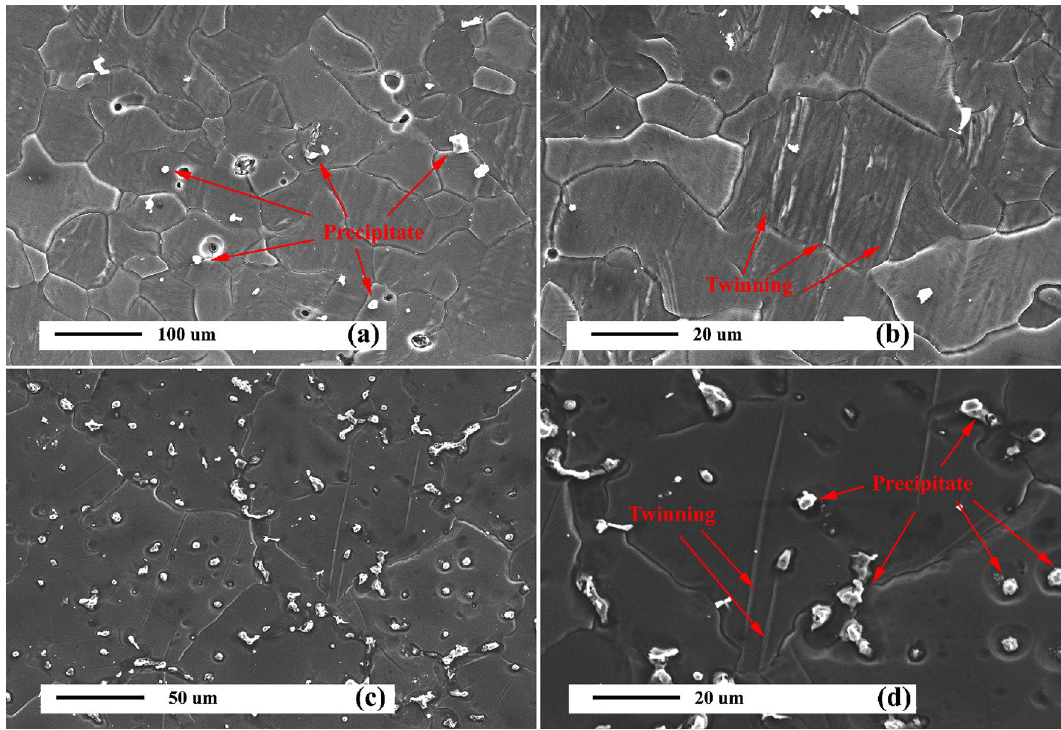
Figure 4. SEM micrographs of unreinforced alloy: ( a ) and ( b ) as-cast, and ( c ) and ( d ) after precipitation Figure 5a–f show the SEM micrographs of the AZ31/5%SiC and AZ31/10%SiC as-cast composites. Relatively homogeneous distribution of SiC particles is seen in the AZ31 matrix. In the higher magnification micrograph (Fig. 5c,f), a matrix/reinforcement interface free of cracks, porosity, and cavities can be seen, which indicates good wettability of SiC particles by Mg melt. The average grain sizes of AZ31/5%SiC and AZ31/10%SiC composites were 30 and 20 μm, respectively. The smaller grain size of the composites compared to the unreinforced alloy is related to the presence of SiC particles and the heterogenic solidification on the surface of the SiC particles, which has caused the refinement 52–54 . However, due to the refinement of the matrix, the number of twins is less than those in the unreinforced sample. Figures 5g–j reveal the SEM micrographs of the AZ31/5%SiC and AZ31/10%SiC aged composites. The rela- tive homogeneous distribution of reinforcement particles is observed in both composites, obtained without any porosity and cracks. The average grain sizes of AZ31/5%SiC and AZ31/10%SiC composites were 16 μm and 10 μm, respectively. Precipitation hardening and increasing the percentage of reinforcement particles caused the grain size to reduce significantly 55 . By decreasing the grain size, the activation energy required to form twins increases 56 . However, Fig. 5i shows the presence of twins in the microstructure, created in aging treatment. As shown in the higher magnification micrographs in Fig. 5h,j, in AZ31/5%SiC and AZ31/10%SiC composites, proper adhesion is created between the reinforcing particles. XRD.